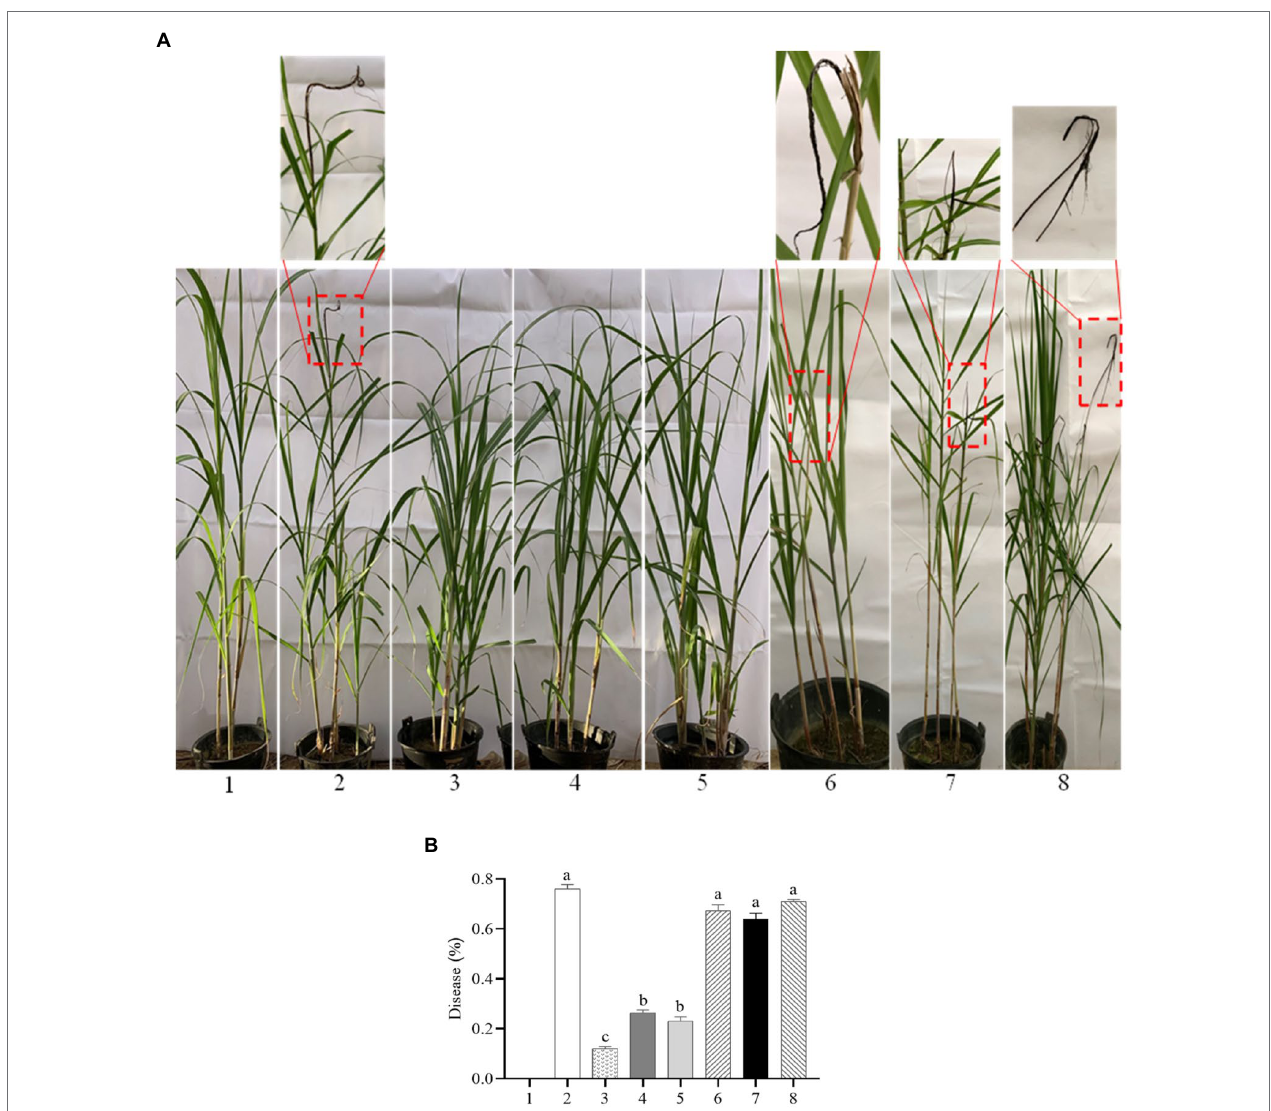
FIGURE 8 | SsCI72380 gene involved in the pathogenicity of S. scitamineum . (A) Symptoms of smut whip. (B) Incidence. Numbers indicate: sterile water (1), Ss16 + + Ss16 − (2), Δ SsCI72380 + + Δ SsCI72380 − (3), Ss16 + + Δ SsCI72380 − (4), Ss16 − + Δ SsCI72380 + (5), COM72380 + + COM72380 − (6), Ss16 + + COM72380 − (7), and Ss16 − + COM72380 + (8) inoculation, respectively. Bars indicate the SE. Different lowercase letters represent a difference at the 0.05